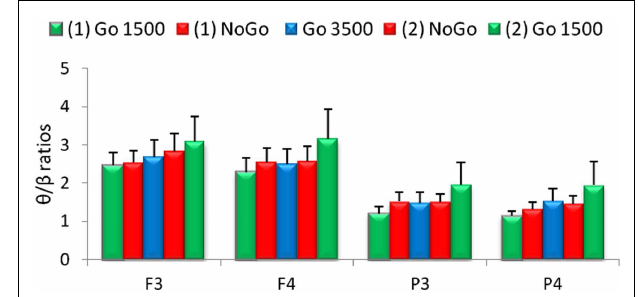
FIGURE 4 | Relative theta/beta ( θ / β ) ratios for frontal (F 3 and F 4 ) and parietal (P 3 and P 4 ) electrodes for the five conditions of the GNG task. No significant differences were found between the various conditions ( n = 53, mean ±